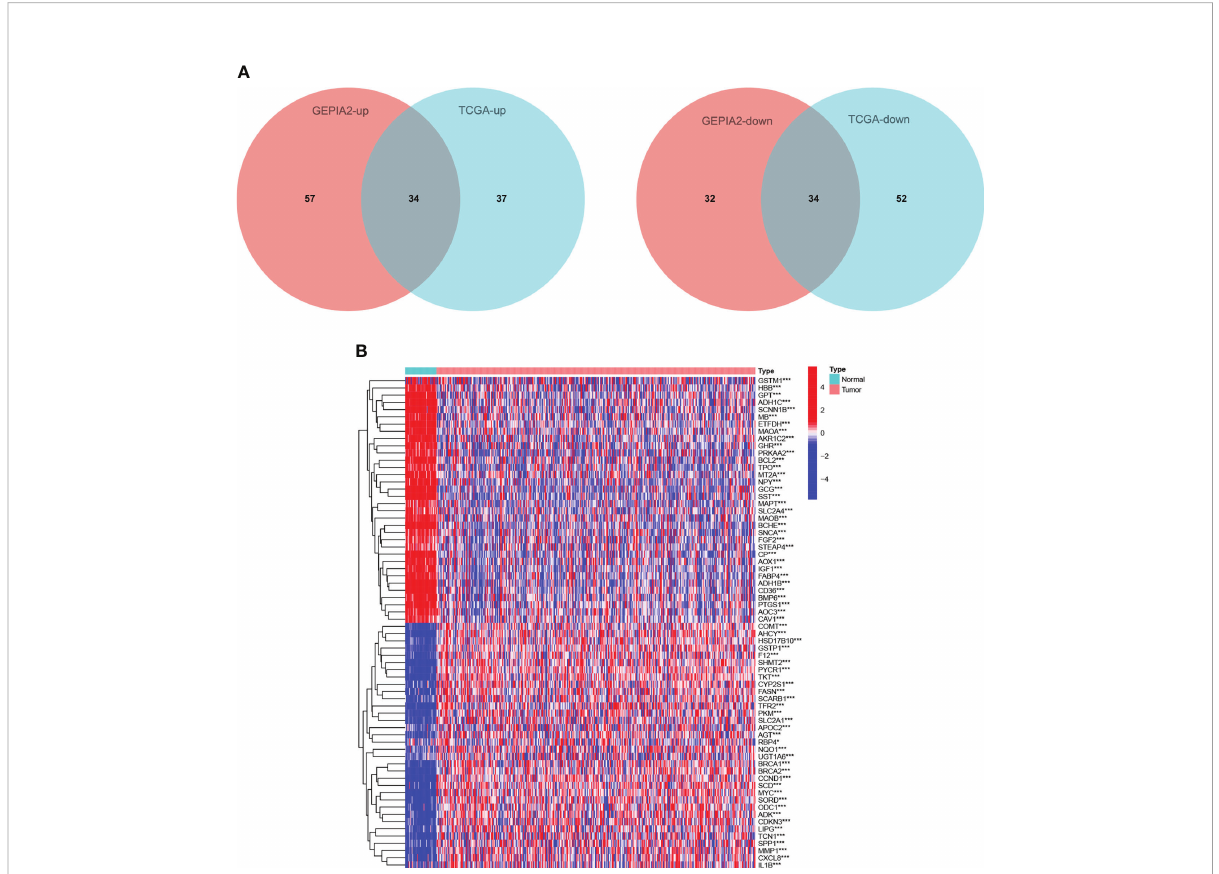
FIGURE 2 Differentially expressed CMRGs. (A) Venn diagram of differential expression of 479 CMRGs in tumor tissues from GEPIA2 and TCGA databases. (B) Heat map of 68 differentially expressed genes in TCGA, Red represents up-regulated expression, blue represents down-regulated expression. TCGA, The Cancer Genome Atlas; GEPIA2, Gene Expression Pro fi ling Interactive